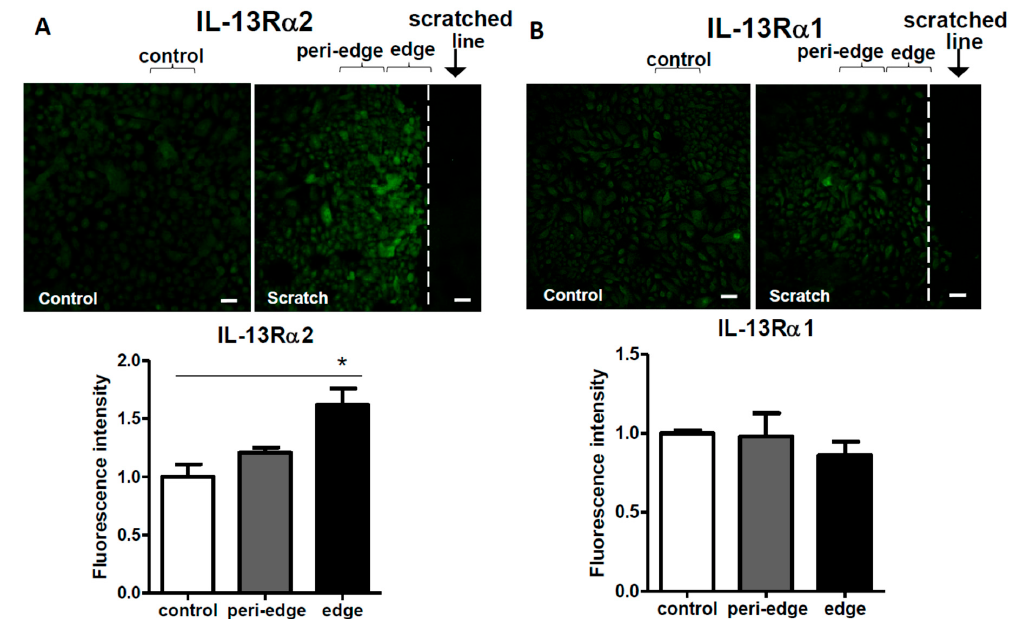
Figure 5. Immunofluorescence analysis for IL-13R α 2 ( A ) and IL-13R α 1 ( B ) proteins. Non-scratched control or scratched confluent keratinocyte sheets were immunostained with anti-IL-13R α 2 or anti-IL-13R α 1 antibodies. Data is shown as the mean ± SEM. * p < 0.05. Scale bar: 50 µm.